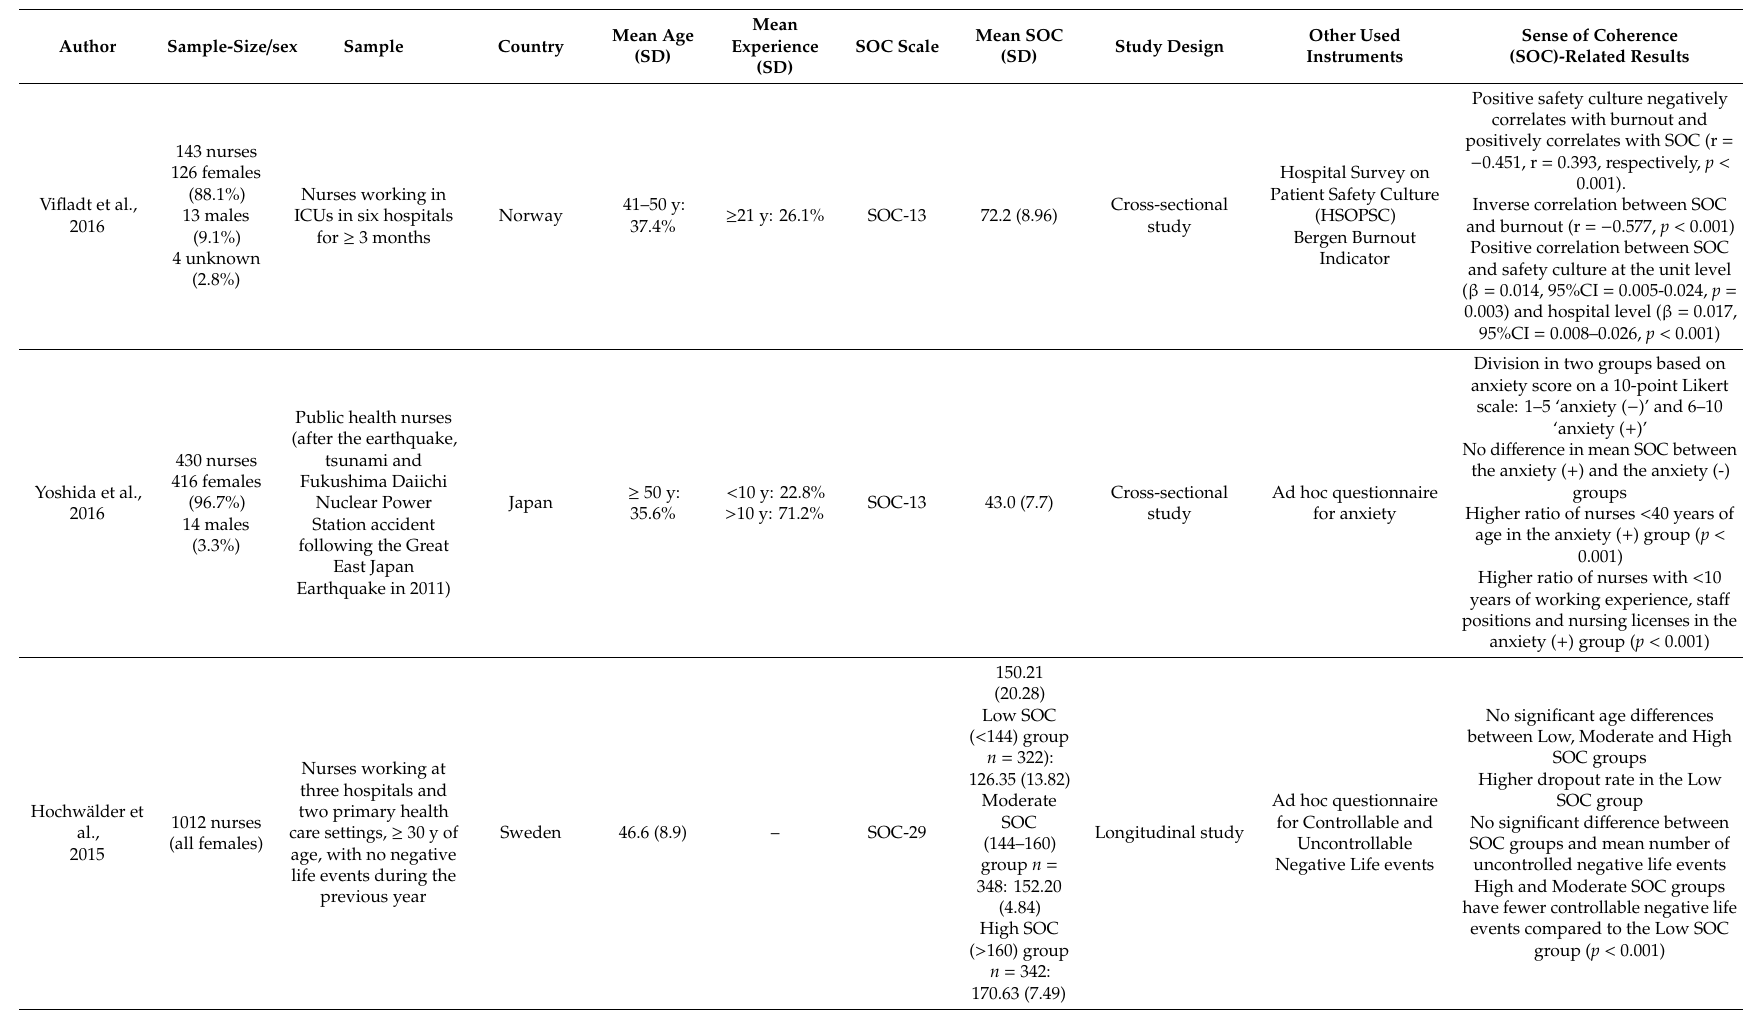
Division in two groups based on anxiety score on a 10-point Likert scale: 1–5 ‘anxiety ( − )’ and 6–10 ‘anxiety ( + )’ No di ff erence in mean SOC between the anxiety ( + ) and the anxiety (-) Ad hoc questionnaire groups for anxiety Higher ratio of nurses < 40 years of age in the anxiety ( + ) group ( p < 0.001) Higher ratio of nurses with < 10 years of working experience, sta ff positions and nursing licenses in the anxiety ( + ) group ( p <